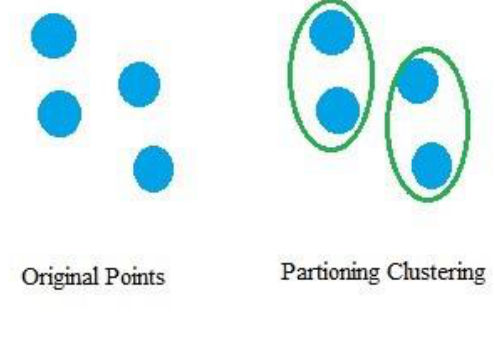
Figure 4. Data points selected by partitioning clustering for cluster formation